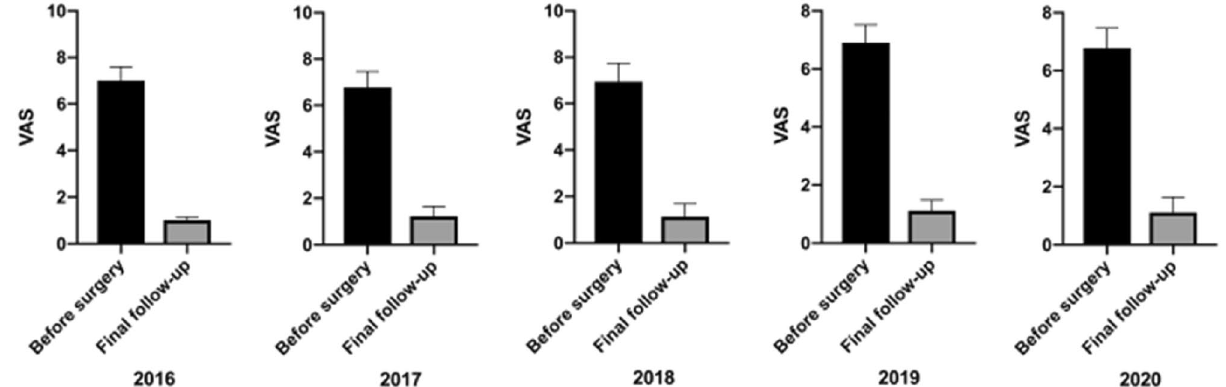
Figure 5. The VAS scores of OVCF patients over 5